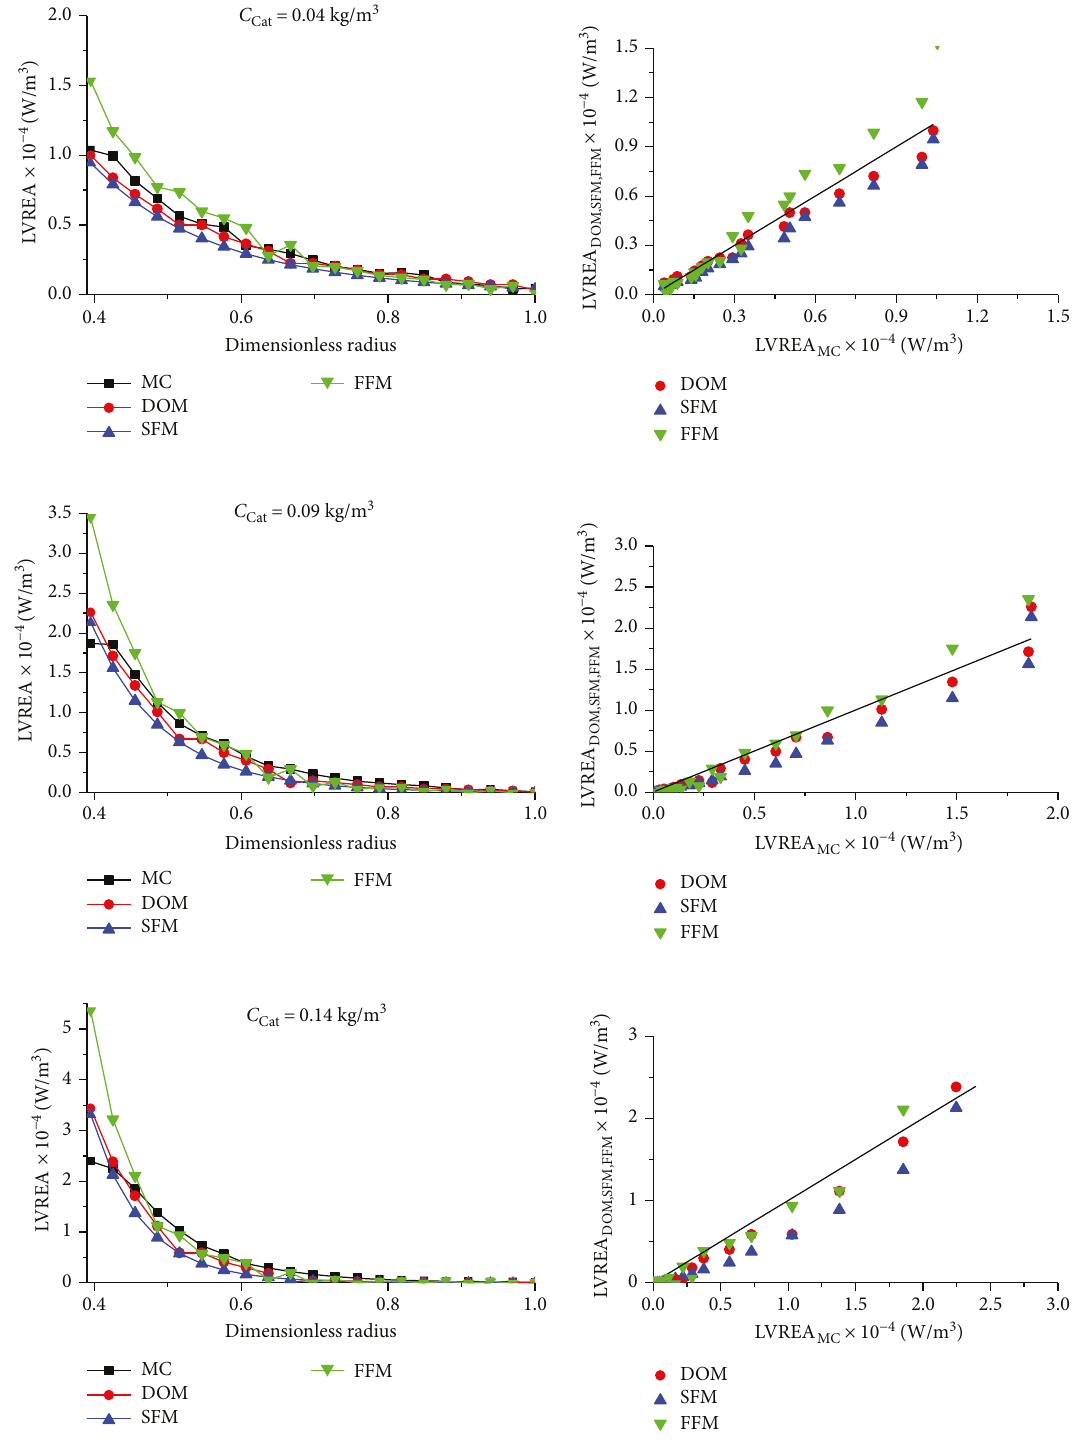
Figure 7: Radial pro fi les of local volumetric rate energy absorption (LVREA) obtained with four- fl ux model at di ff erent catalyst concentration for system 2 and its comparison with the other